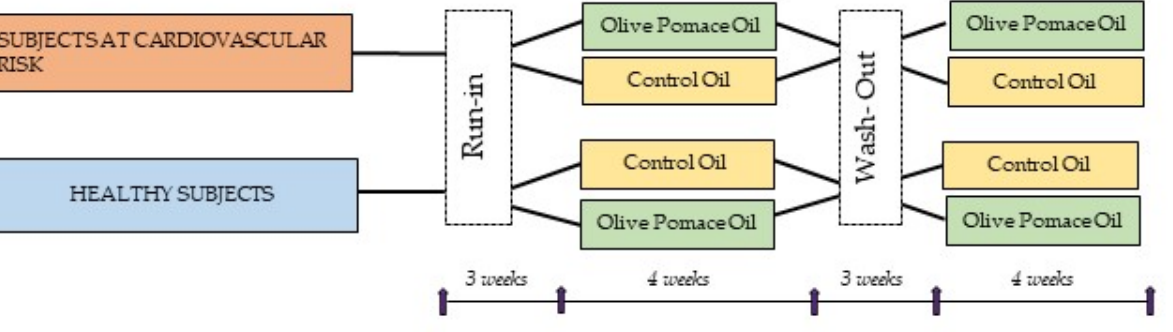
Figure 1. Study design. The arrows indicate the visits